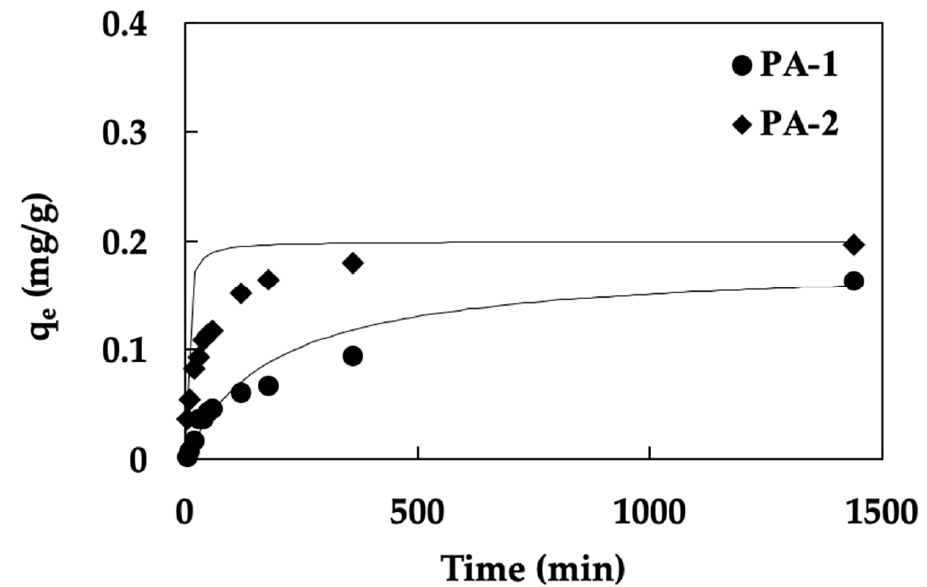
Figure 3. Adsorption kinetics of fluoride on PA-1 and PA-2 (pH 7, solid/liquid ratio 15 g/L, temperature 25 °C, vertical shaker at 200 rpm for 0.24 h). Solid lines exhibited the obtained data from the pseudo-second order kinetic model).